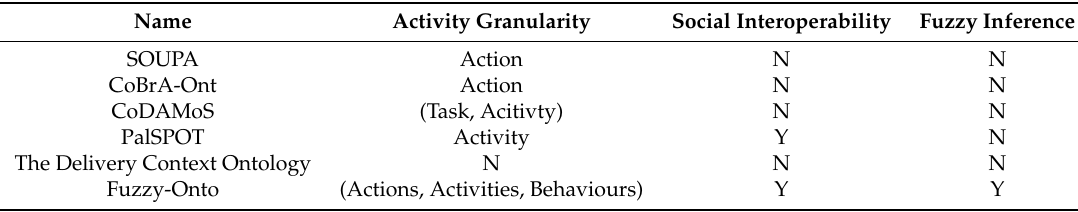
Table 4. Comparison of different ontologies for activity